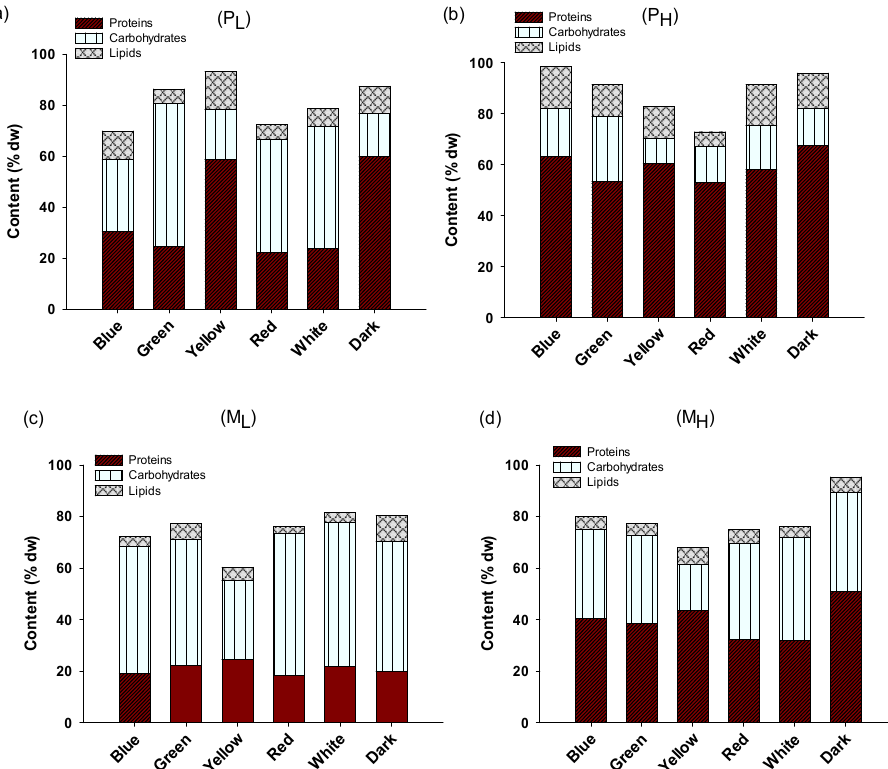
Figure 3. Biochemical composition of A. protothecoides cultivated in different light wavelengths under photoautotrophic conditions with ( a ) low peptone and ( b ) high peptone concentration, and in mixotrophic conditions with ( c ) low peptone and ( d ) high peptone concentration. Each bar represents the average of n = 3 replicates.